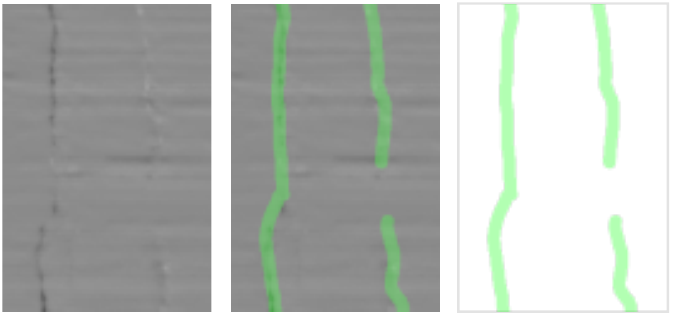
Figure 3. Wide annotation strokes mark rough crack course. Annotation is not precisely pixel-accurate. ( Left ): Photometric surface structure model. ( Right ): Crack annotation mask. ( Middle ): Overlay of surface structure model and annotation